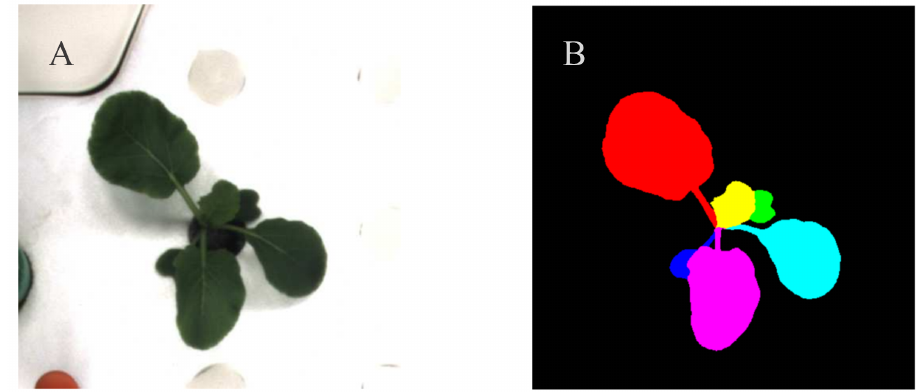
Figure 1. Annotation example of the ground truth leaf images; Image ( A ) shows an example of a single raw image and ( B ) shows the same image after annotation in RGB-D